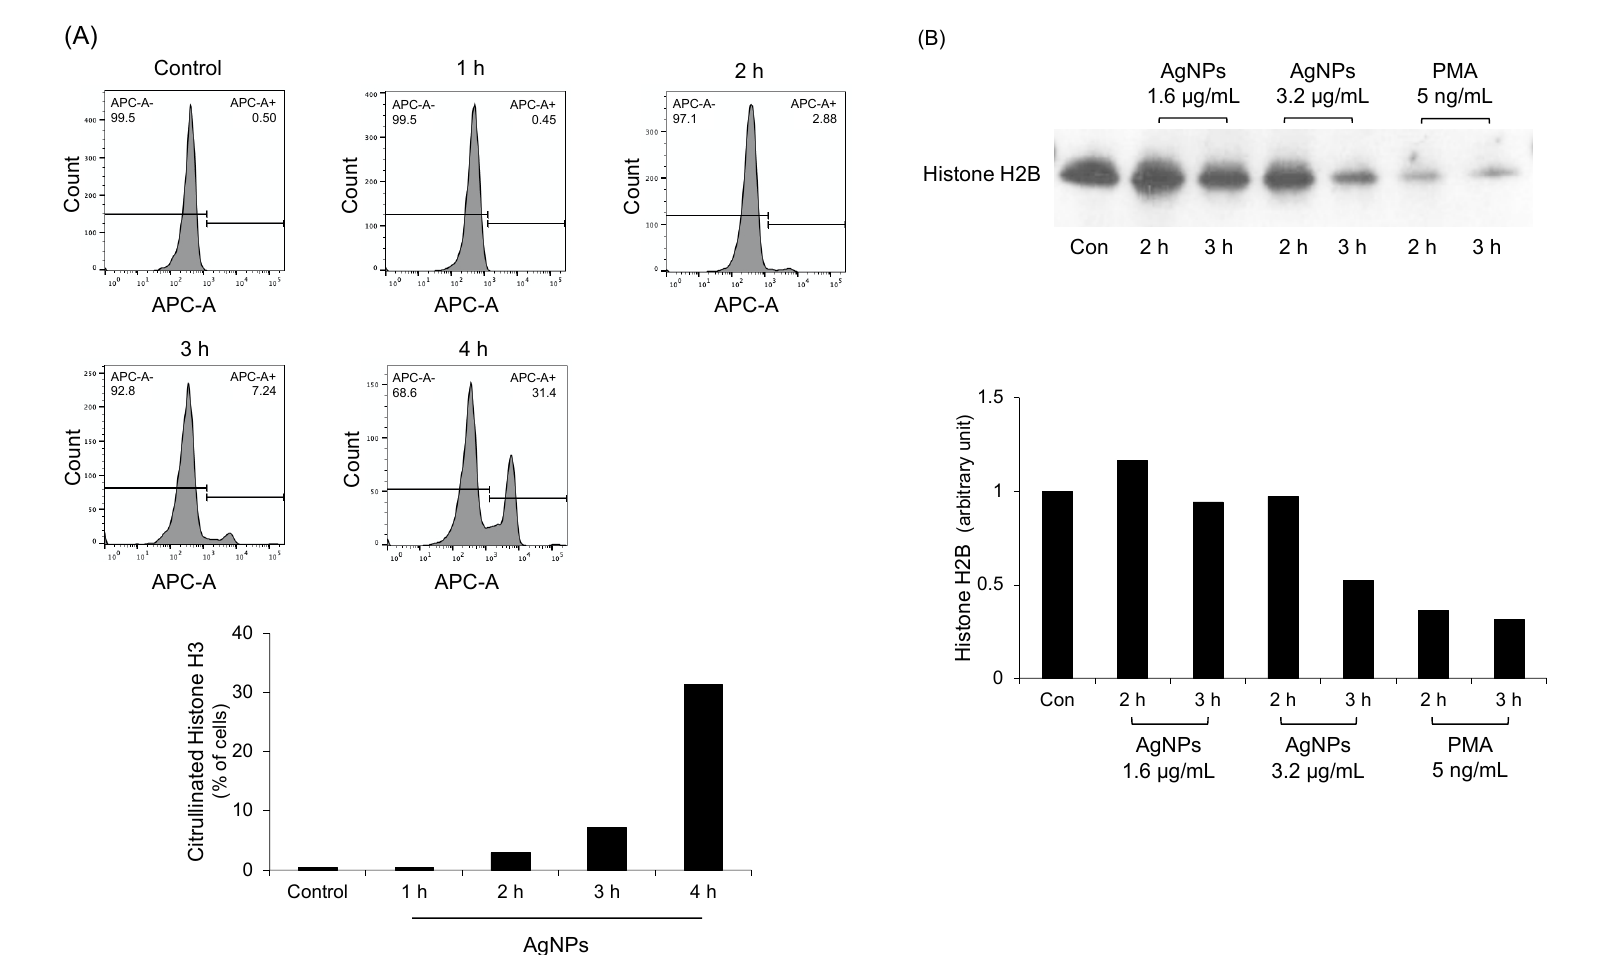
Figure 7. Histone citrullination and degradation in 5 nm AgNP-treated neutrophils. ( A ) Human neutrophils were treated with 1.6 µ g/mL 5 nm AgNPs for each indicated time point and citrullinated histone H3 was measured using flow cytometry. ( B ) Western blotting of histone H2B. Human neutrophils were treated with 5 nm AgNPs or PMA for 2 or 3 h, and total histones were isolated. Histone H2B levels were detected by western blotting to verify histone degradation. All experiments were performed in duplicate and repeated three times with different